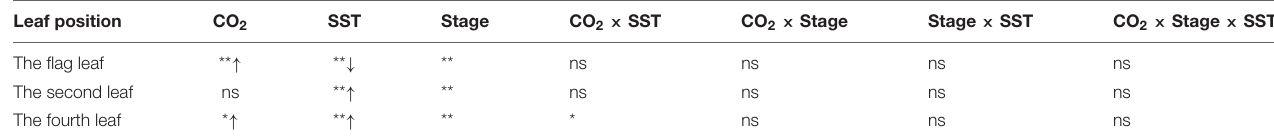
TABLE 6 | Significance test for the Pn of flag leaf (CK, SR1/3, and SR1/2 crops), second leaf (CK and LC1 crops) and fourth leaf (CK and LC3 crops) of WYJ27 at different stages as affected by elevated CO 2 and different source-sink treatments in 2017. Leaf position CO 2 SST Stage CO 2 × SST CO 2 × Stage The flag leaf ** ns ns ns